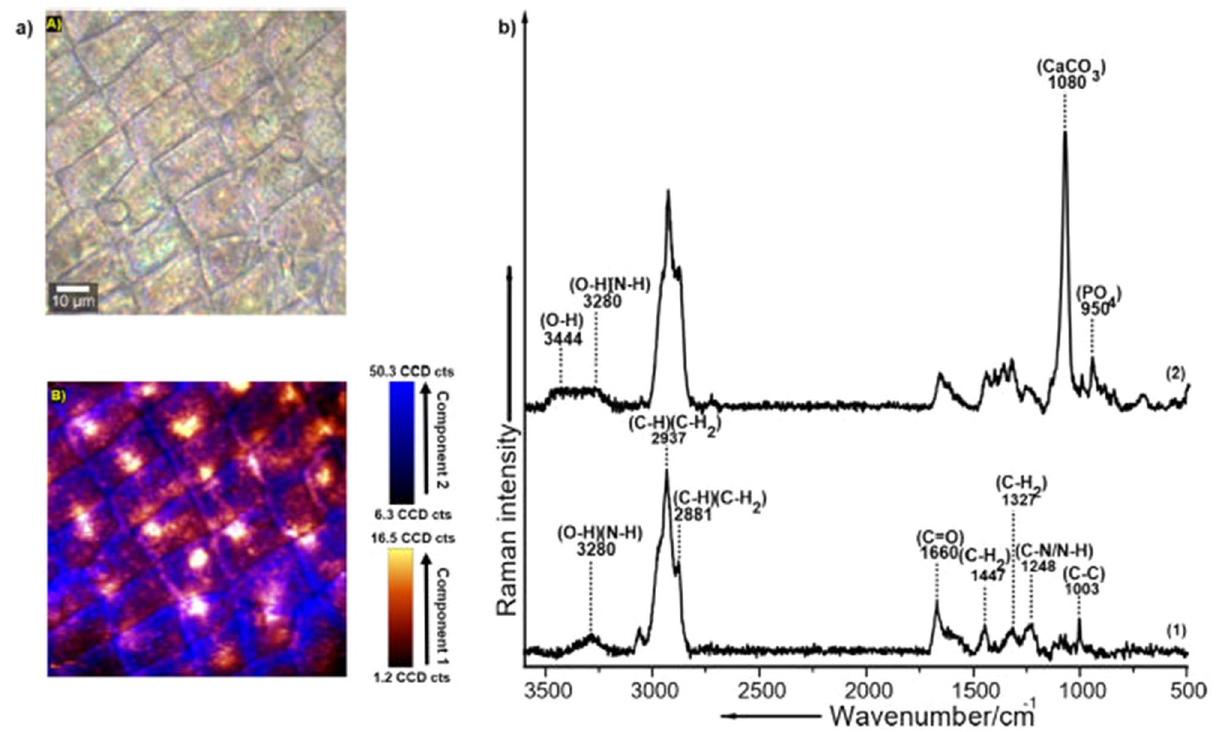
Figure 2. Distribution of organic and inorganic components within the carapace of D. magna visualized via micro-Raman spectroscopic imaging; (a) (A) Bright-field microscopic image representing the distal integument of the carapace and (B) corresponding false colored Raman image acquired from an exemplary replicate sample indicating intensity-based differential distribution of the demixed spectral components color coded in orange (component 1) and blue (component 2), (b) Demixed Raman spectrum representing the organic and inorganic components of the carapace: (1) Component 1, representing spectral signatures corresponding to organic components (α-chitin and proteins) and (2) Component 2, representing spectral signatures comprising of both organic and inorganic components (ACC and phosphates). The color scale represents the relative